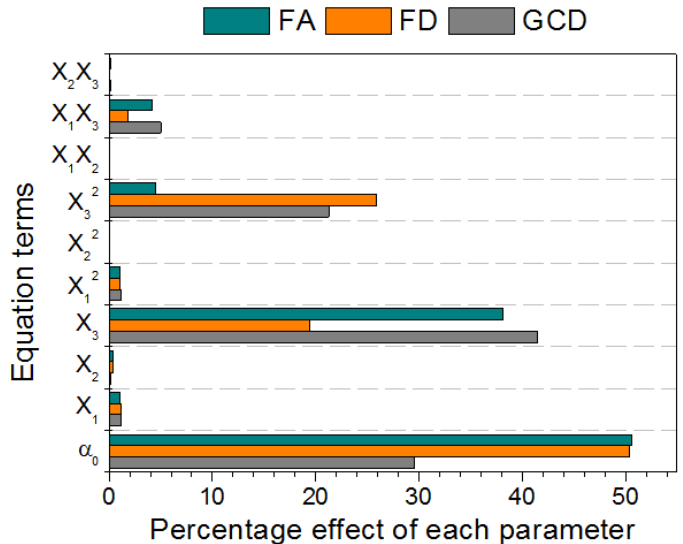
Figure 15. Pareto chart analysis.